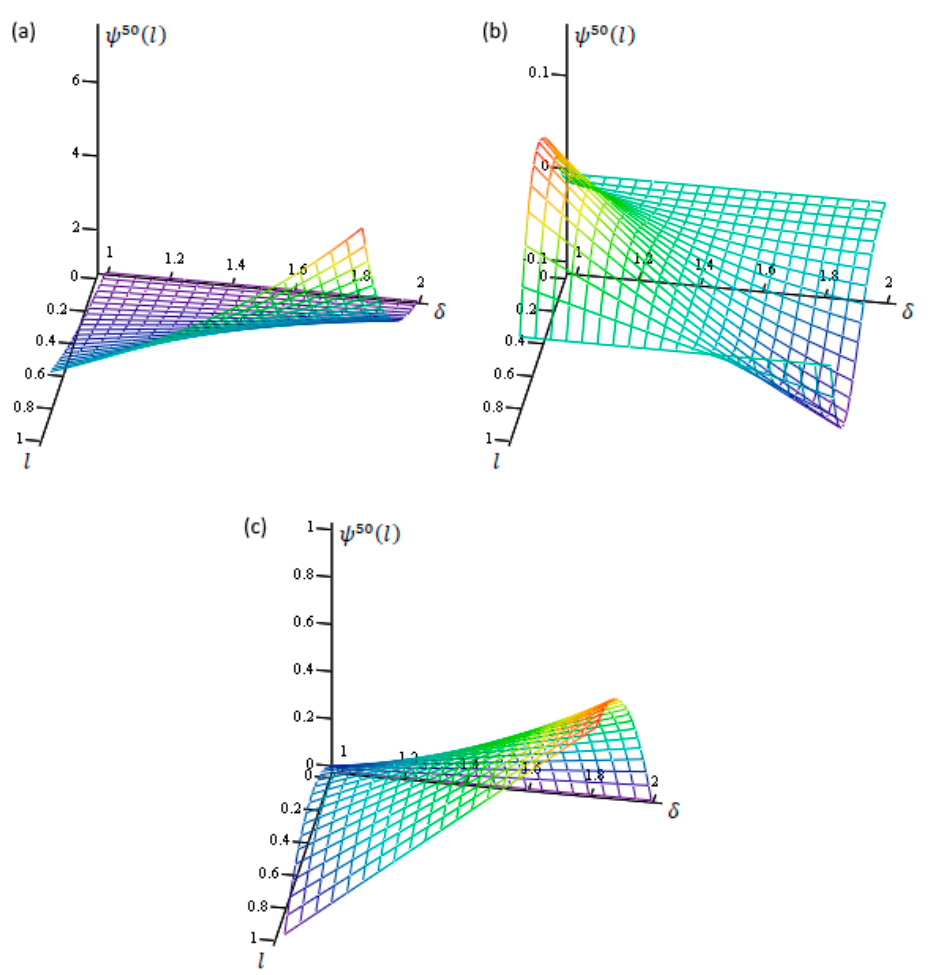
Figure 1. The 3 D computational values of the RKDM when l i ∈ J and δ ∈ ( 1, 2 ] : ( a ) Example 1; Figure 1. The 3𝐷 computational values of the RKDM when 𝑙 (cid:3036) ∈ 𝒥 and 𝛿 ∈ (cid:4666)1,2(cid:4671) : ( a ) Example 1; ( b ) ( b ) Example 2; and ( c ) Example Example 2; and ( c ) Example 3.